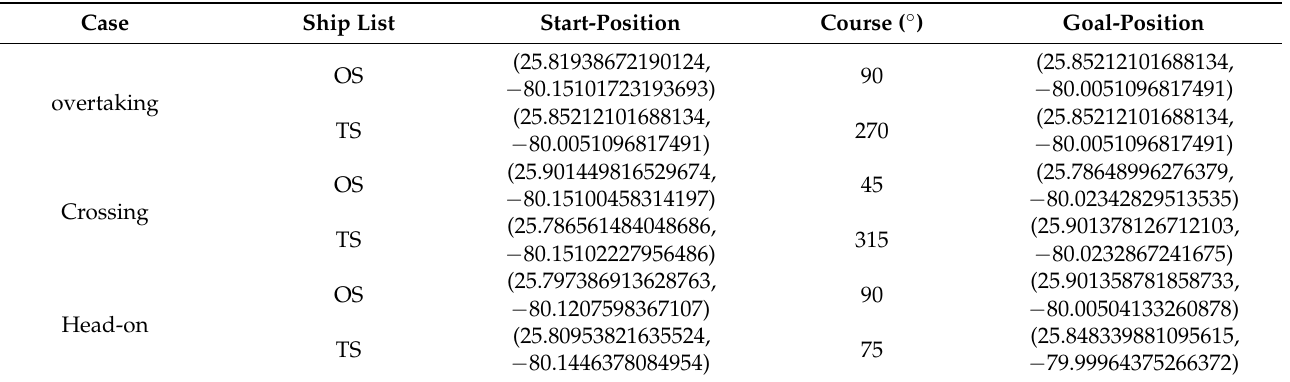
Table 1. Typical two-ship encounter